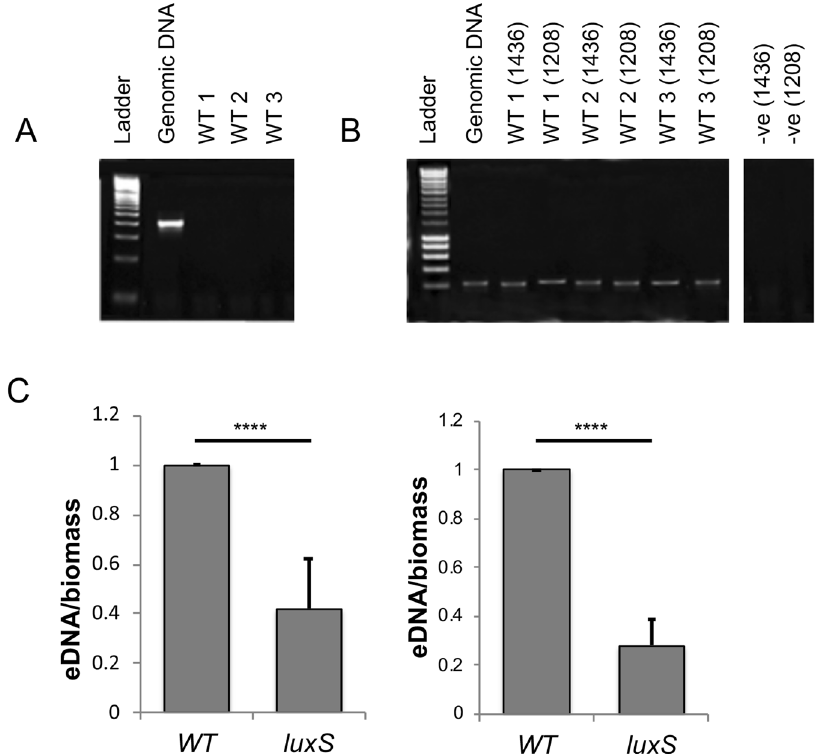
Figure 3. Presence of phage and eDNA in C . difficile biofilms. The phage origin of DNA isolated from WT biofilms was confirmed by PCR, using primers for 16S ( A ) and two phage genes (CDR20291_1436 and CDR20291_1208) ( B ). The negative controls were run on a different part of the same gel. The gel pictures were trimmed with no adjustment to the intensities. WT-1–3 are three biological replicates. ( C ) Total eDNA extracted from the WT and luxS mutant biofilms after 24 h and 72 h, normalised to the biofilm biomass. N = 3, **** p < 0.0001 as determined by Mann-Whitney U